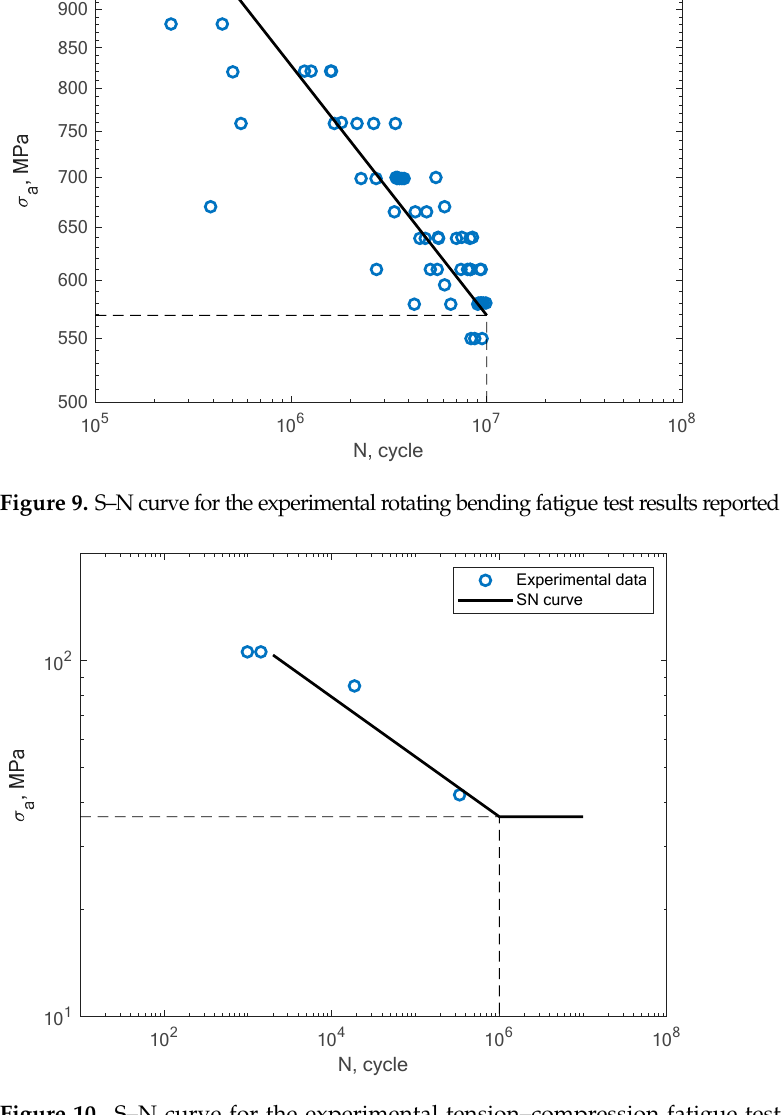
Figure 10. S–N curve for the experimental tension–compression fatigue test results reported by Cruces et al. [7] .